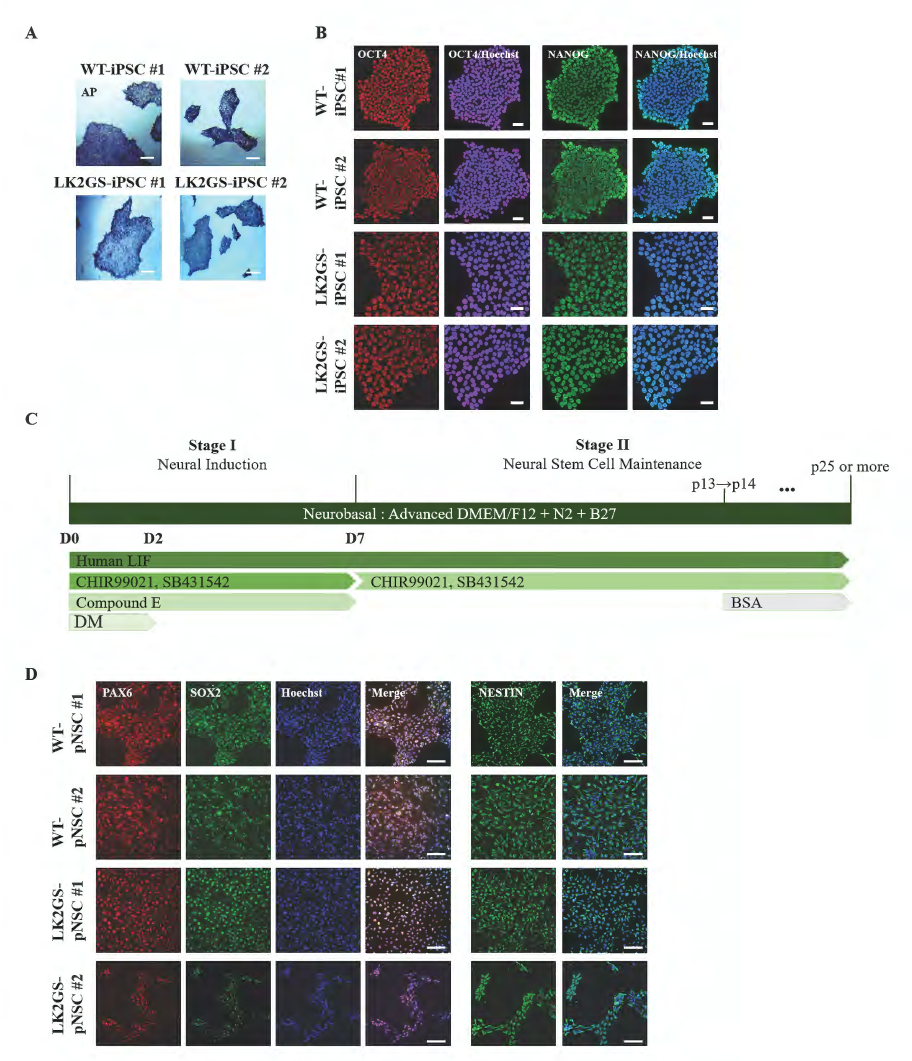
Figure 1. Generation of pNSCs using PD-patient-specific iPSCs. ( A ) AP staining of WT-iPSCs and LK2GS-iPSCs. Scale bars are 200 µ m. ( B ) Immunostaining of pluripotent stem cell markers in WT- and LK2GS-iPSCs. Scale bars are 50 µ m. ( C ) Schematic diagram of differentiation human iPSCs into neural stem cells. ( D ) Immunostaining of neural stem cell markers (PAX6, SOX2, NESTIN) in WT- and LK2GS-pNSCs. Scale bars are 125 µ